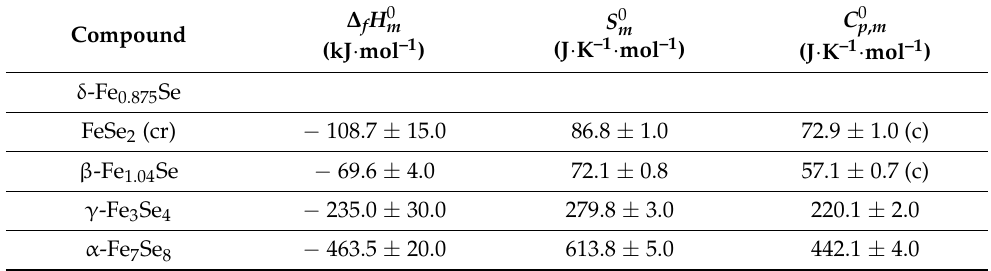
Table 2. The thermodynamic data for several iron selenides (T =298.15 K, p = 0.1 MPa) [71].